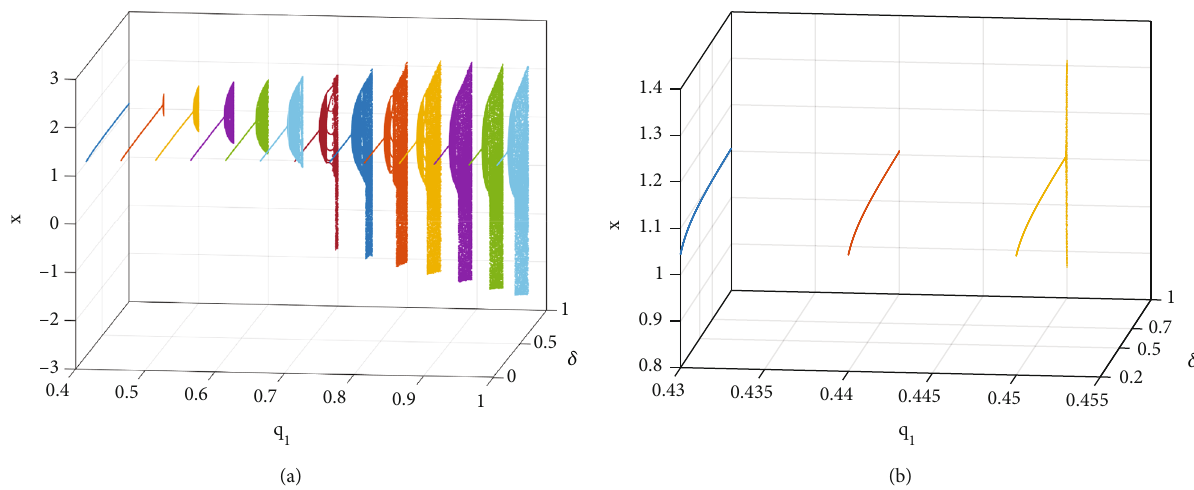
∈ ½ 0 : 4, 0 : 99 (cid:2) . (b) q are varied. (a) q 1 1